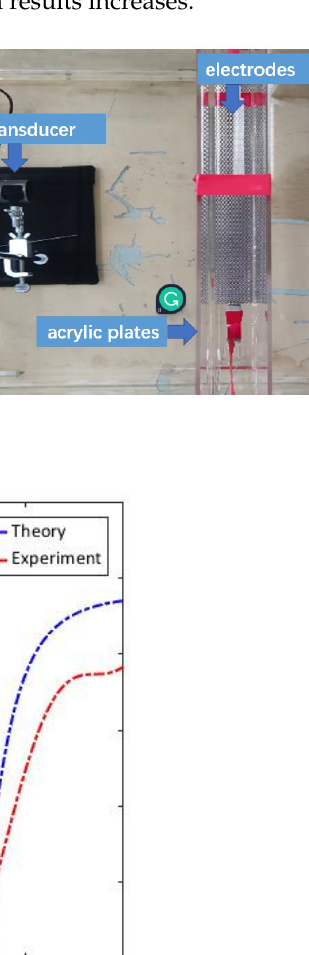
Figure 7. Experimental setup diagram.